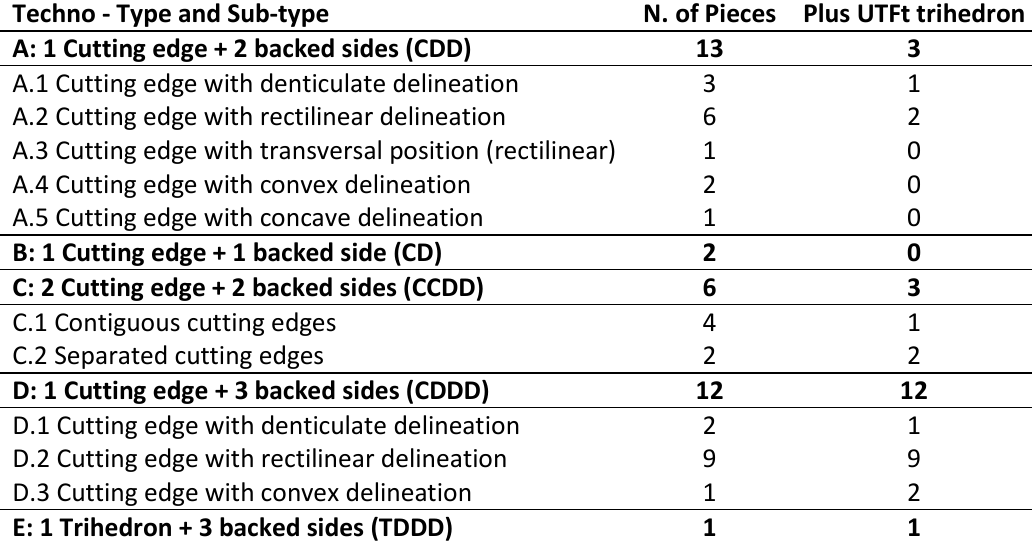
Table 7. Techno-type and subtype defined by the combination of UTFt and UTFp. The column “plus UTF trihedron” indicates how many trihedrons are present on the pieces (please note that this column refers the number of UTFt Trihedrons and not to the number of